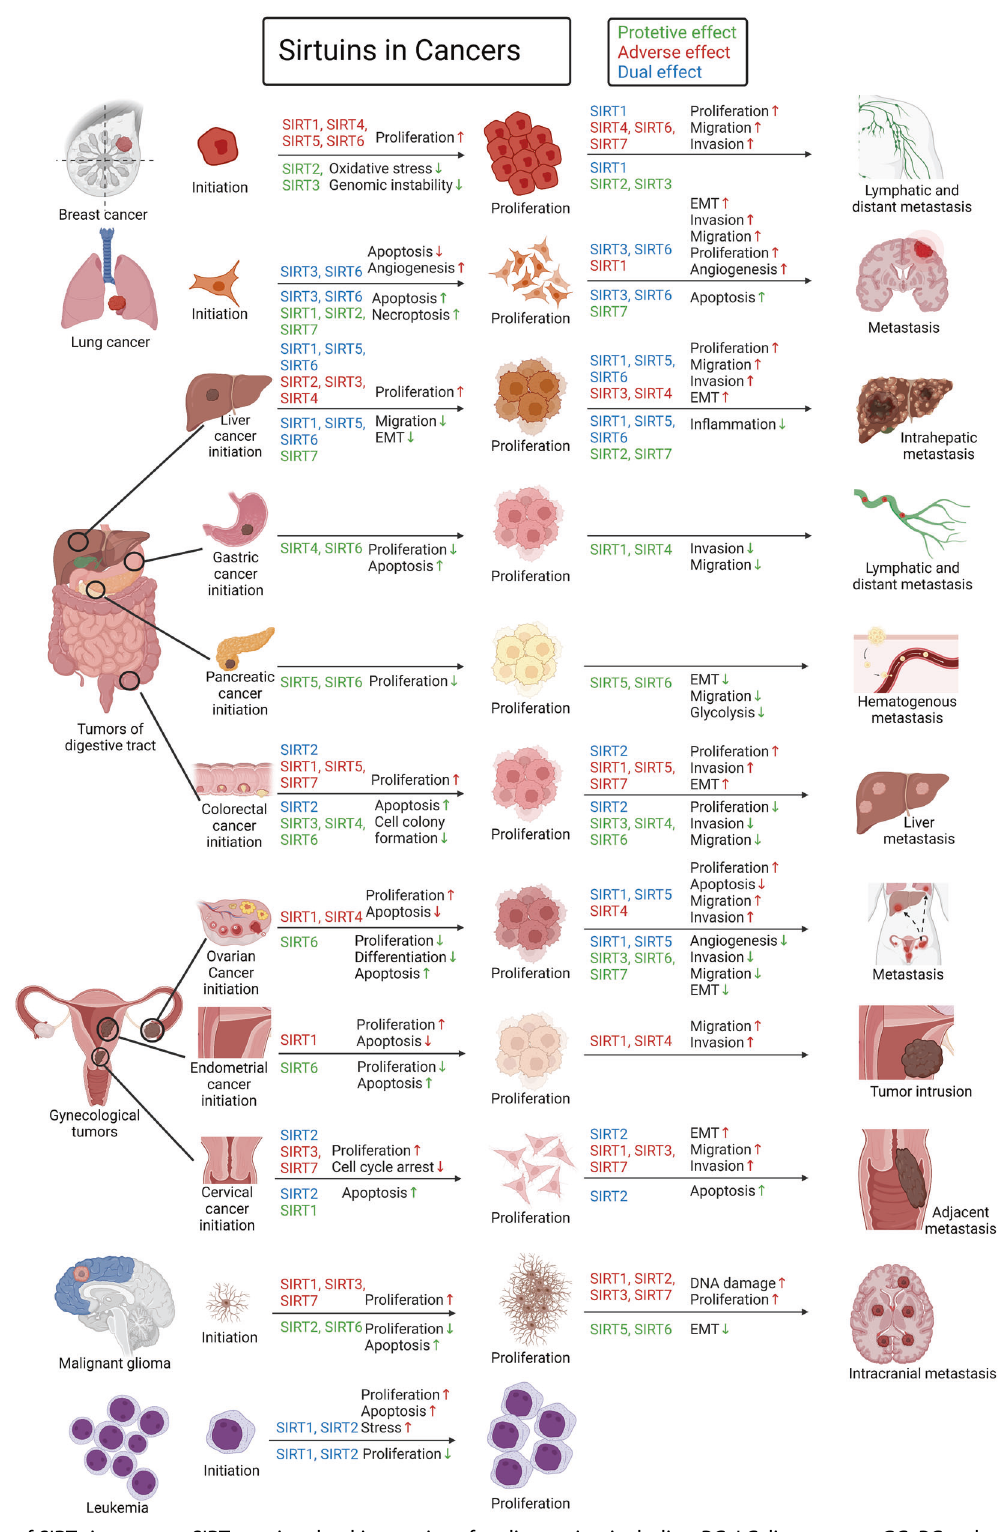
Fig. 9 The roles of SIRTs in cancers. SIRTs are involved in a series of malignancies, including BC, LC, liver cancer, GC, PC, colorectal cancer, OC, EC, CC, malignant glioma, and leukemia. SIRTs act as tumor promoters (marked in red color), tumor suppressors (marked in green color), or both suppressor and promoter (marked in blue color). Major events in solid tumor development consist of tumor initiation, tumor proliferation, and tumor metastasis. Between these events, processes including cell proliferation, oxidative stress, apoptosis, angiogenesis, EMT, migration and invasion are promoted or inhibited. Depending on the tumor location, the metastasis site also varies, including lymph nodes, distant organs, liver, adjacent organs, etc. https://biorender.com